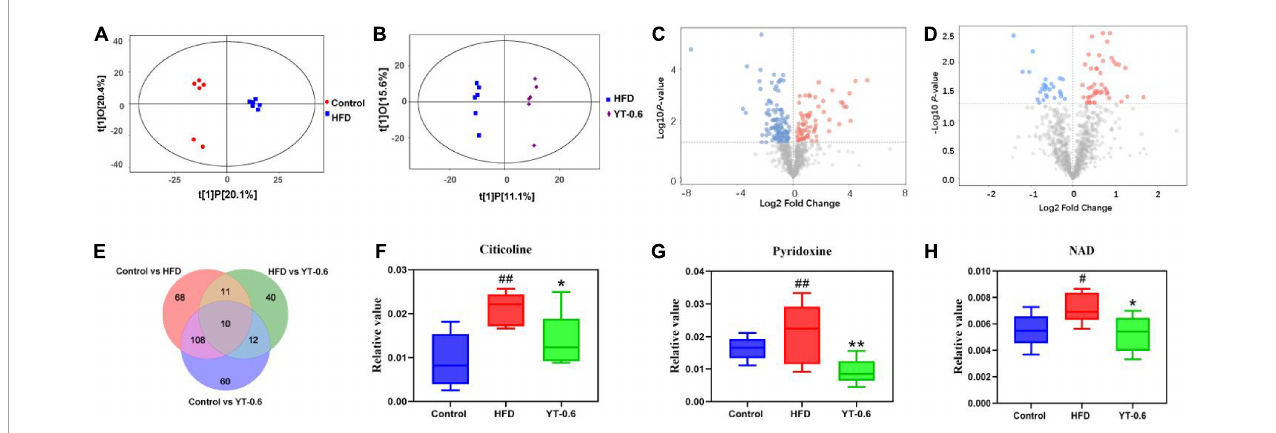
FIGURE5 YT extract altered the associated metabolic profiles in HFD-fed mice. (A) Orthogonal partial least squares discriminant analysis (OPLS–DA) of the control vs. HFD groups. (B) OPLS-DA of HFD-fed vs. the YT-0.6 g/kg group. (C) A volcano plot of control vs. HFD groups. (D) A volcano plot of HFD-fed vs. the YT-0.6 g/kg group. (E) Venn diagram of differential metabolites. (F) Three representative differentially expressed metabolites, # p < 0.05 and ## p < 0.01 vs. the control group; * p < 0.05 and ** p < 0.01 vs. the HFD group.